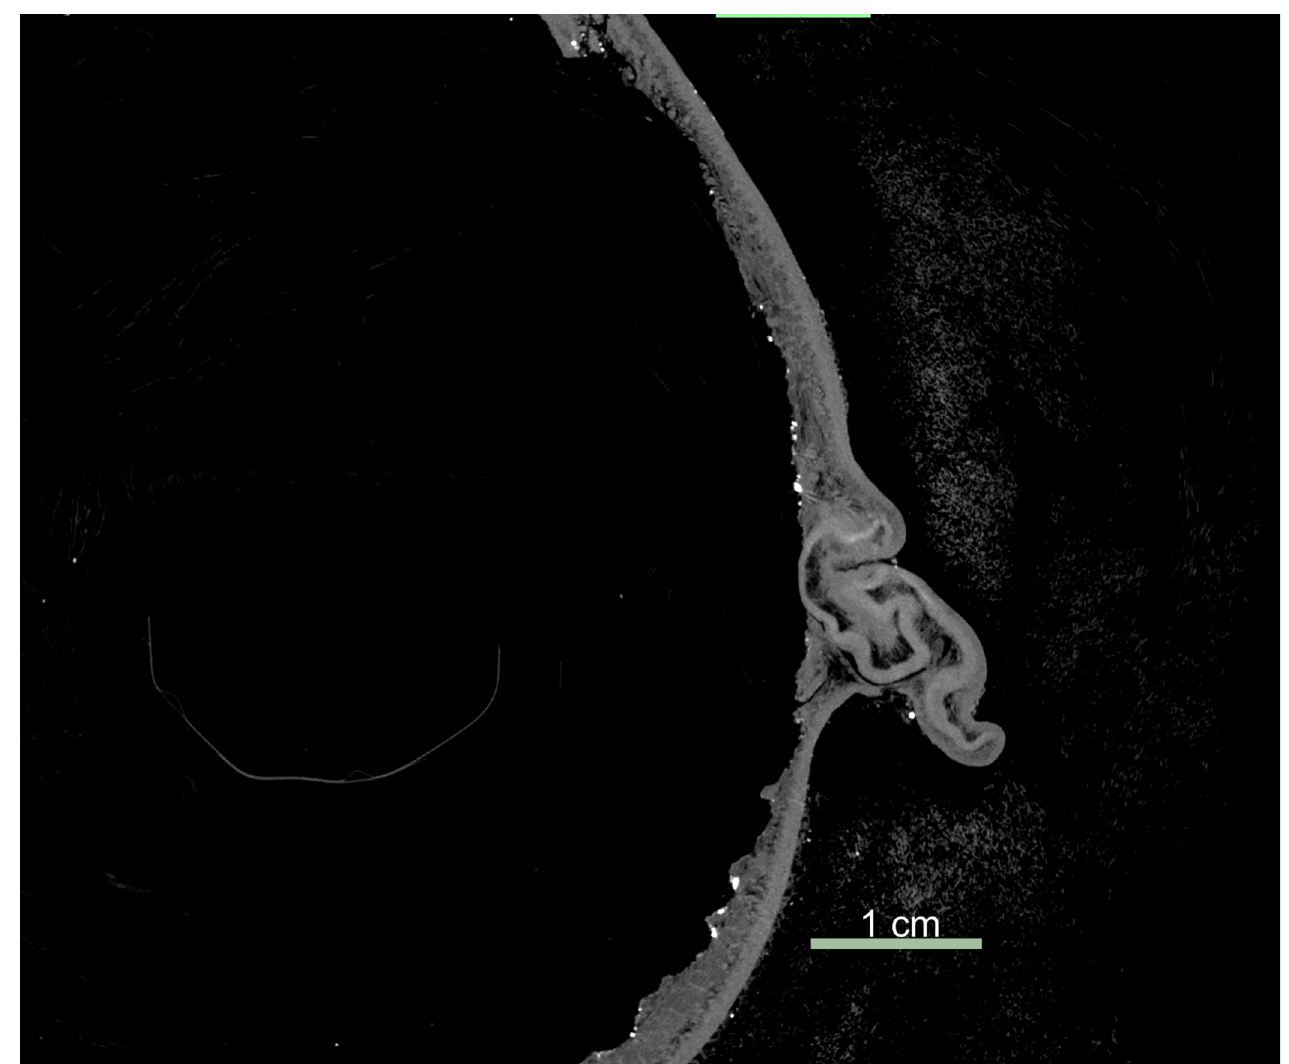
Fig 7. Micro-CT (75 μ m scan) axial slice of the right auditory canal and